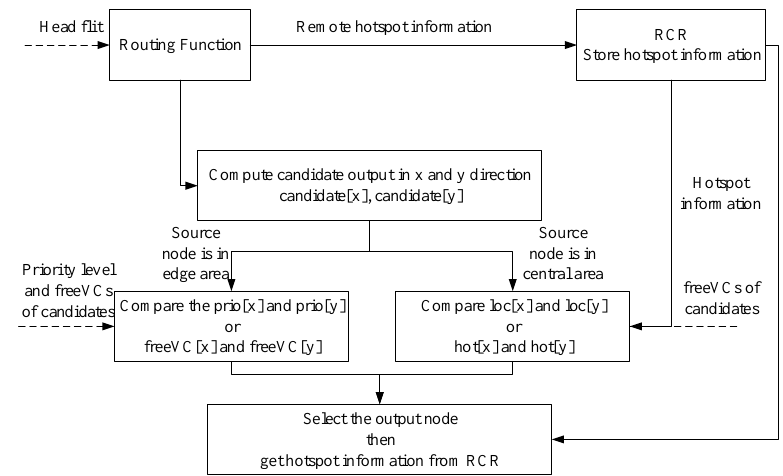
Figure 8. The workflow of